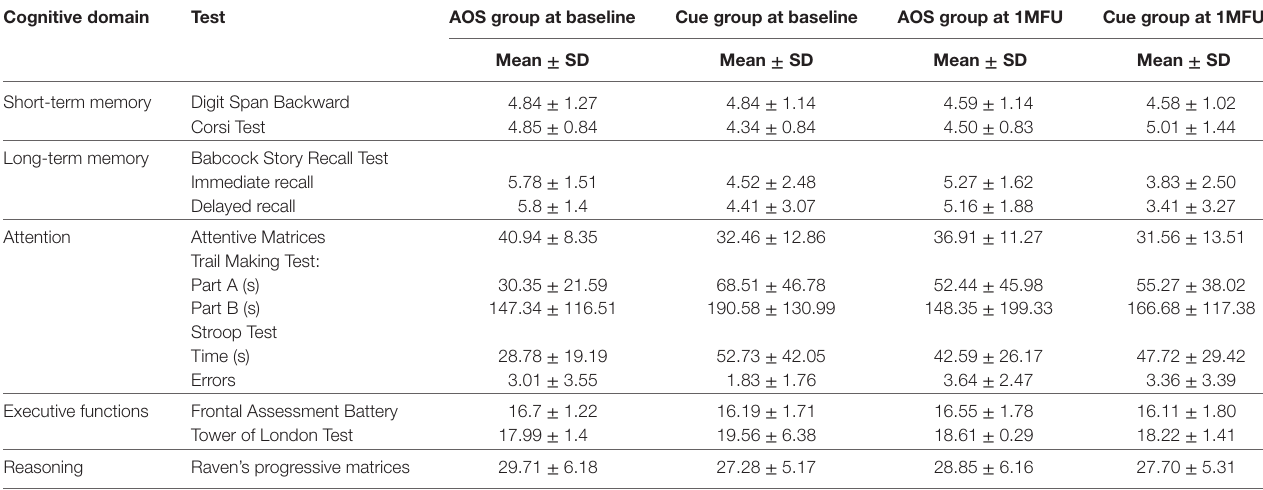
TablE 2 | Cognitive profile of patients with Parkinson’s disease at baseline and at 1-month follow-up